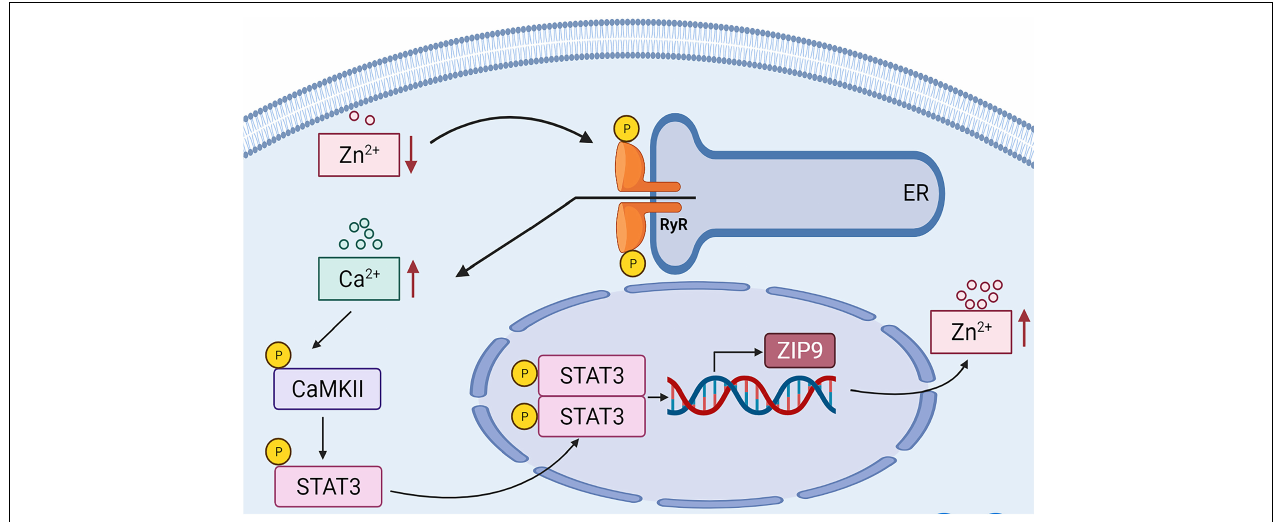
FIGURE 8 | Cellular endogenous protective mechanism induced by zinc